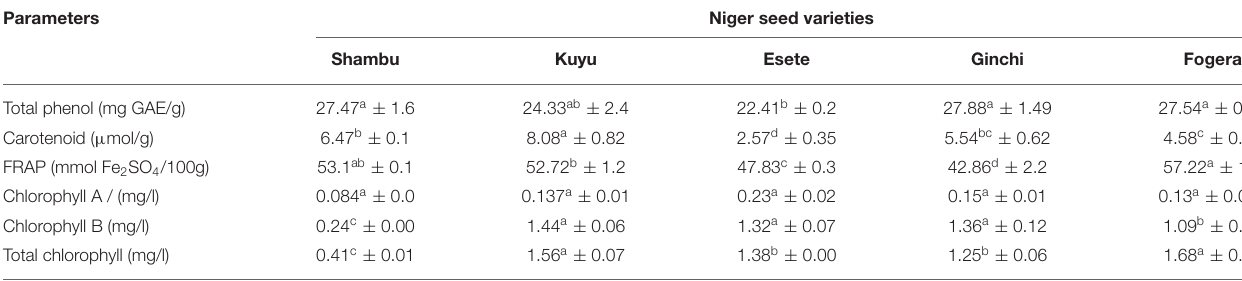
TABLE 3 | Total antioxidant contents and properties of the niger seed varieties. Parameters